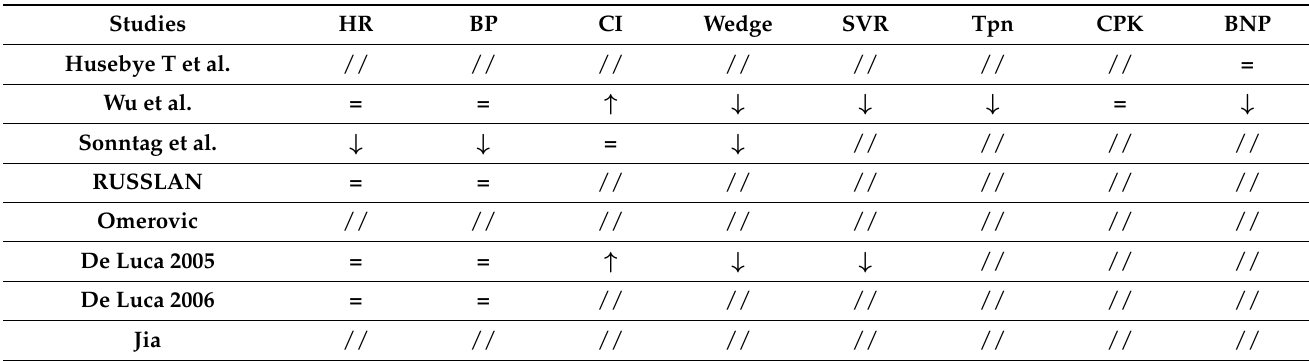
Table 4. Qualitative haemodynamic effect of Levosimendan in studies involved in